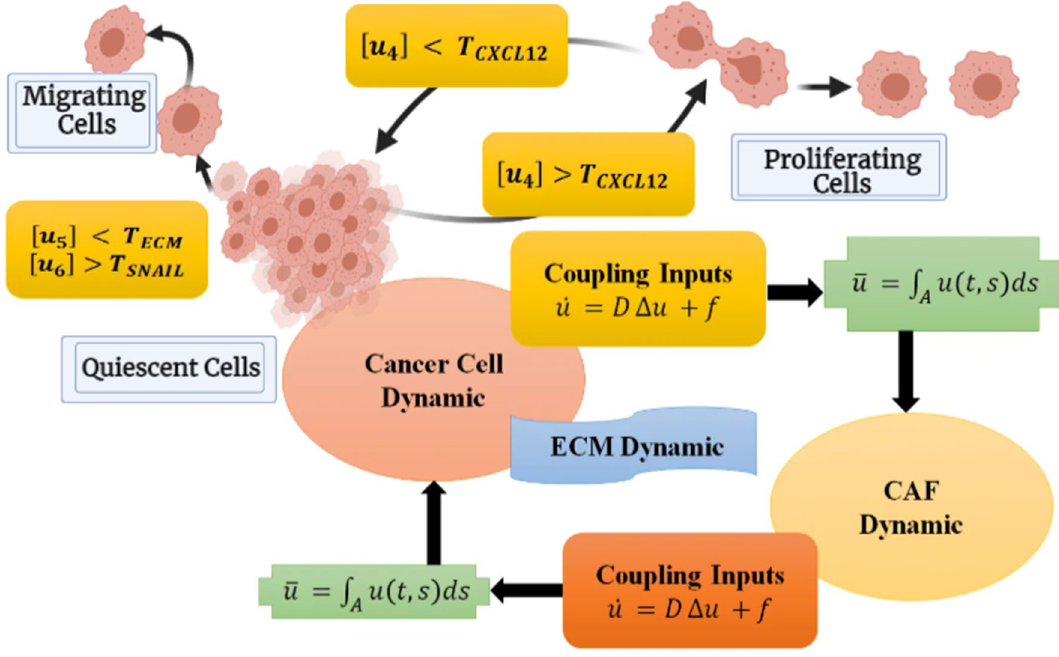
Figure 5. The multi-structure model for determining each cancer cell status. In this figure, u indicates the communicating signals which are transferred between cancer cells and CAFs in the tumor microenvironment (TGFβ and LIF molecules from cancer cells to CAFs, and CXCL12 and TGFβ from CAFs to cancer cells). Also, u u u 5 , and 6 represents CXCL12, ECM, and SNAIL concentration in the model. Furthermore, letter A indicates 4 , the surface area of a cancer cell or CAF which received a transduction signal and T implies the threshold amount of each signal which is indexed.